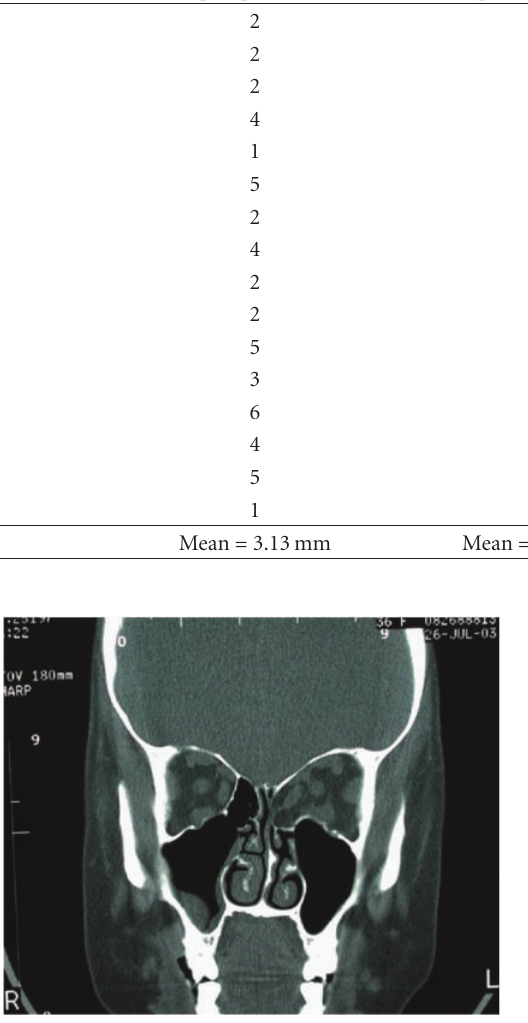
Figure 3: Postoperative photograph of same patient following